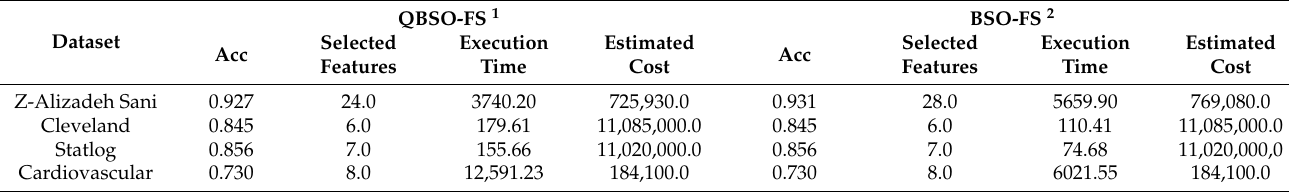
Table 3. Comparison method between QBSO-FS and BSO-FS.